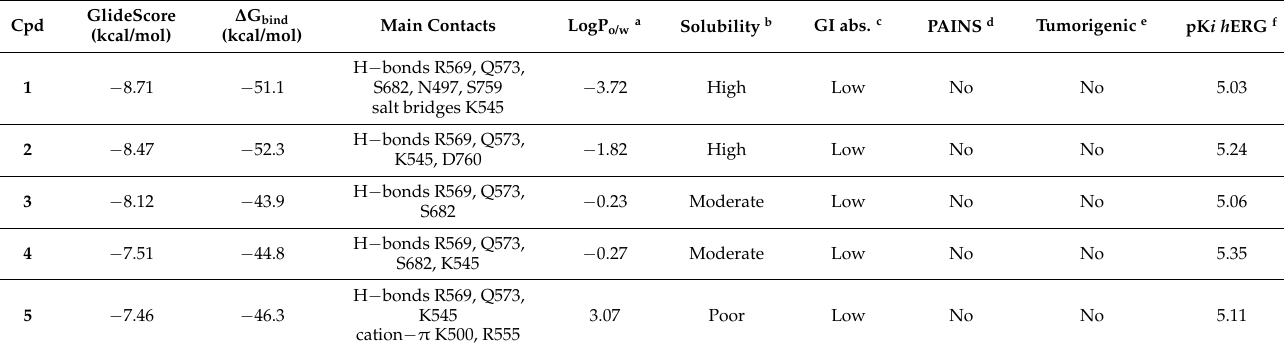
Table 1. Final hits and their computational parameters derived from in silico